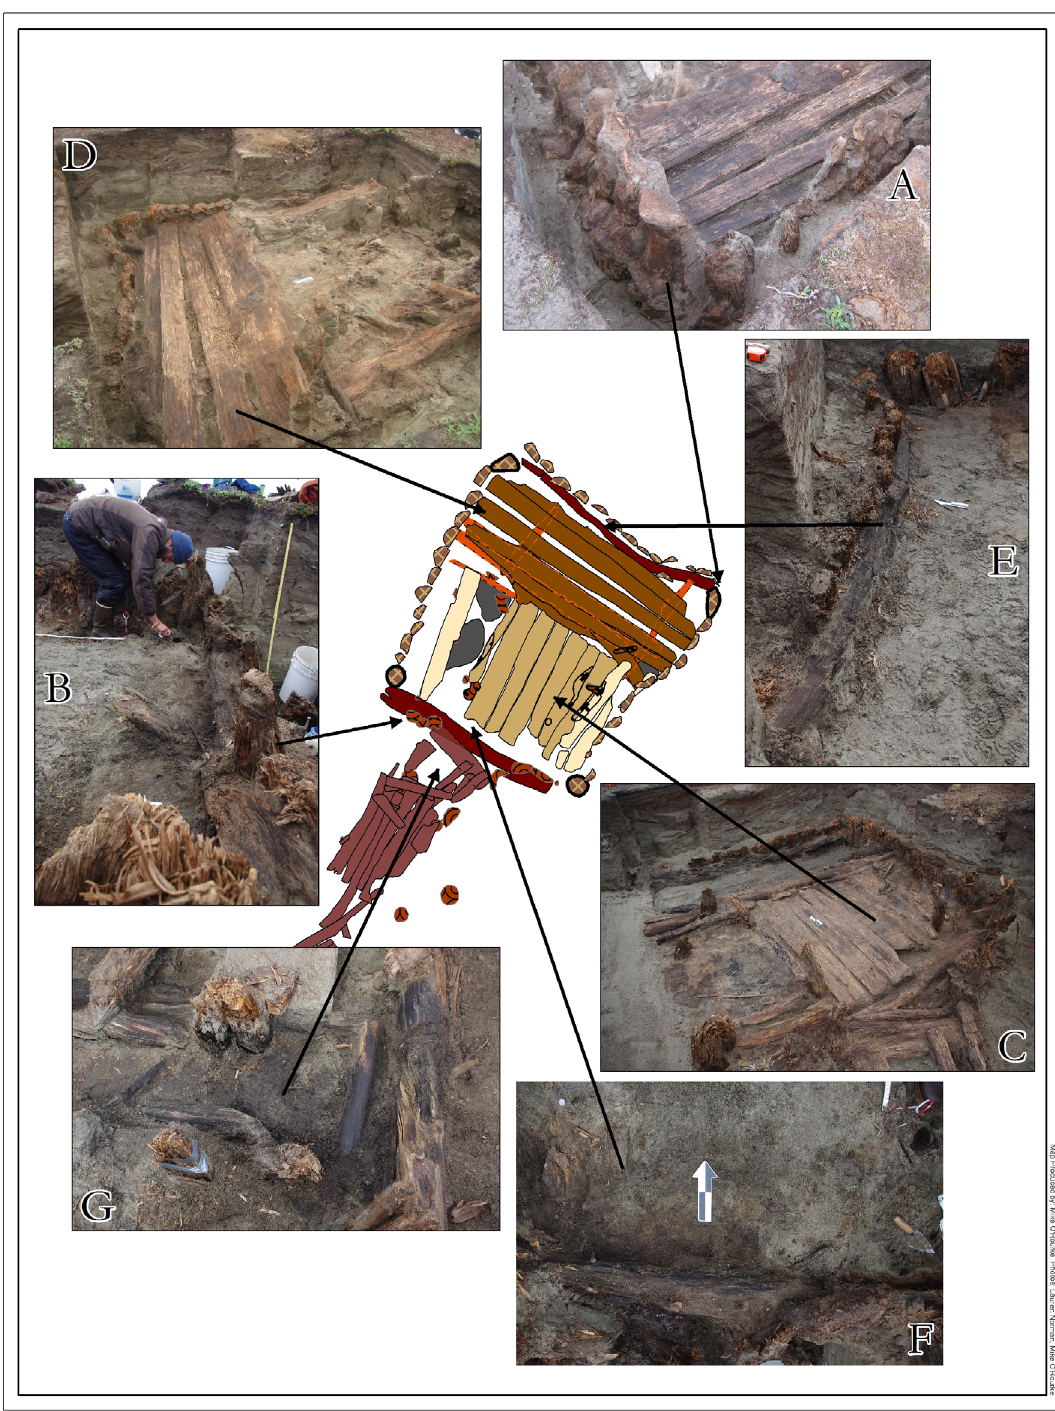
Figure 5: Feature 87 main room features. A: Back and side walls at north east corner; B. Front wall, including sill log and front wall posts; C. Main room floor; D. Back platform and side benches; E. Back sill log and back wall; F. Katak matrix and front sill log in main room; G. Tunnel articulation, with supporting posts/split